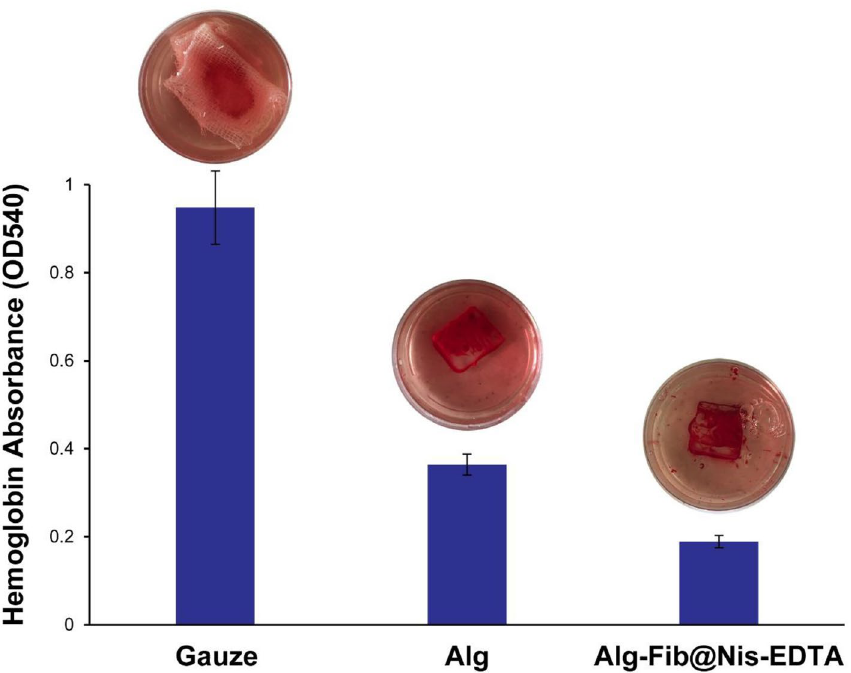
Figure 6. In vitro blood coagulation test. The absorption of the hemoglobin in the rinsing water was measured in 540 nm. The images of the rinsing water from the three samples of gauze dressing, Alg hydrogel, and Alg- Fib@Nis-EDTA hydrogel are displayed to imply the remarkable differences. Data are mean ± SD (n =